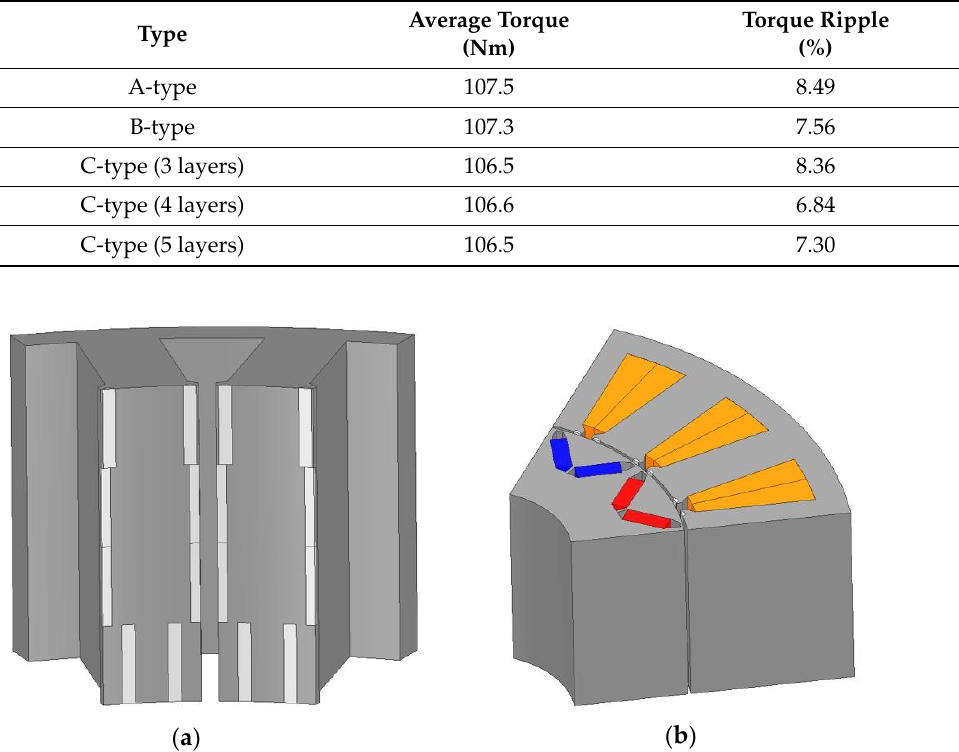
Figure 11. 3D periodic model with the 4-layer wedge skew with radius of 1.6 mm and position of 0.5 mm: ( a ) stator; ( b ) stator and rotor.